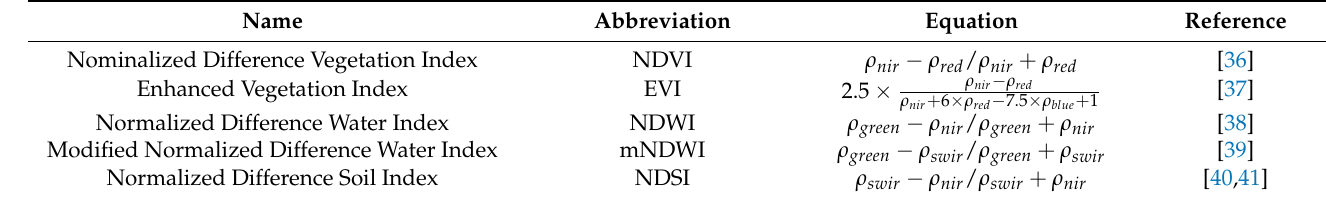
Table 3. Formulas of the spectral indices used in this